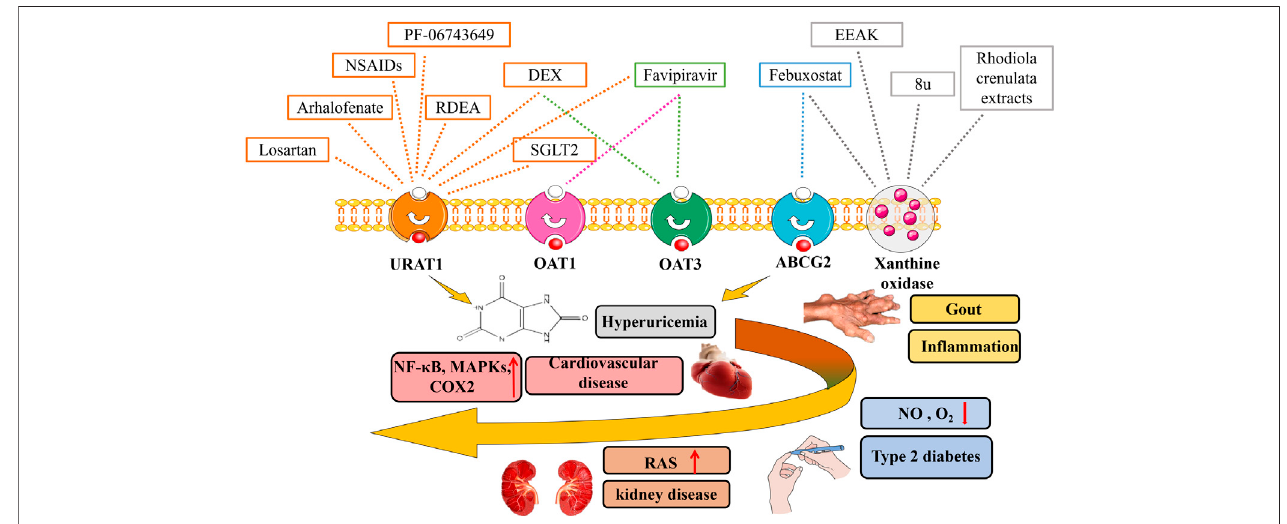
FIGURE 2 | Urat-lowering drugs in hyperuricaemia-related diseases. Hyperuricaemia has been proven to be associated with multiple diseases including gout, chronic kidney disease, cardiovascular diseases, metabolic syndrome. The discovery of urate transporters provides new ideas for the development of drugs for the research of hyperuricaemia. In addition to urate transport inhibitors, xanthine oxidase inhibitors, SGLT2 inhibitors, as well as novel urat-lowering drugs like EEAK, Favipiravir, PF-06743649 have been summarized.